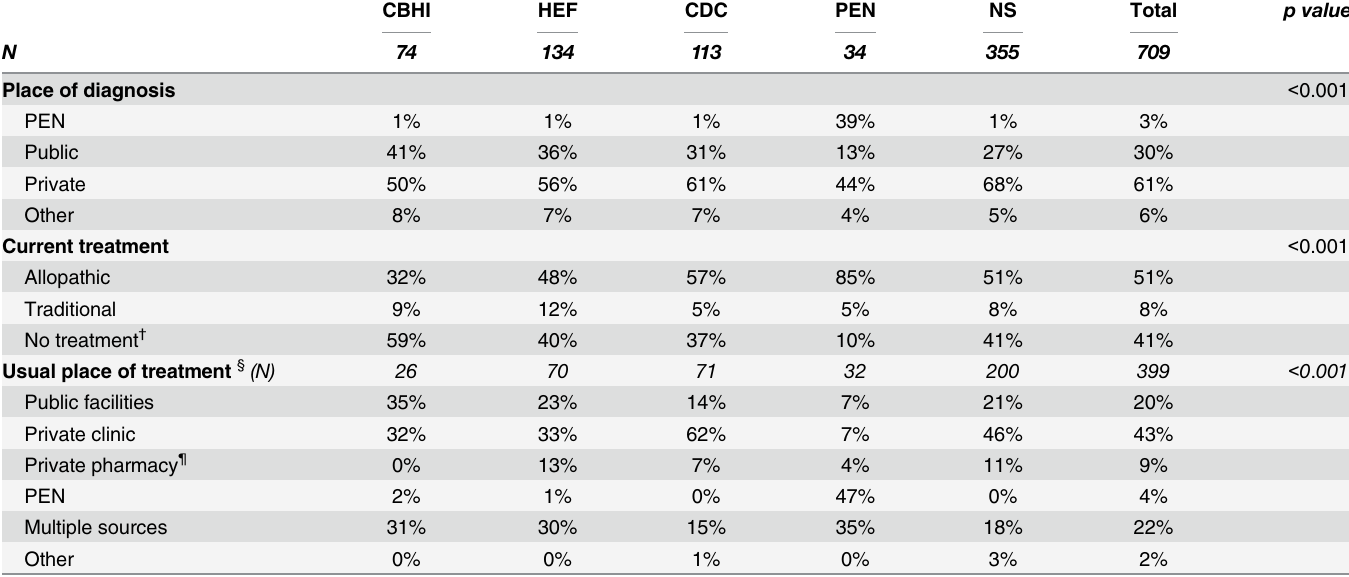
Table 3. Diagnostic and treatment pathways §